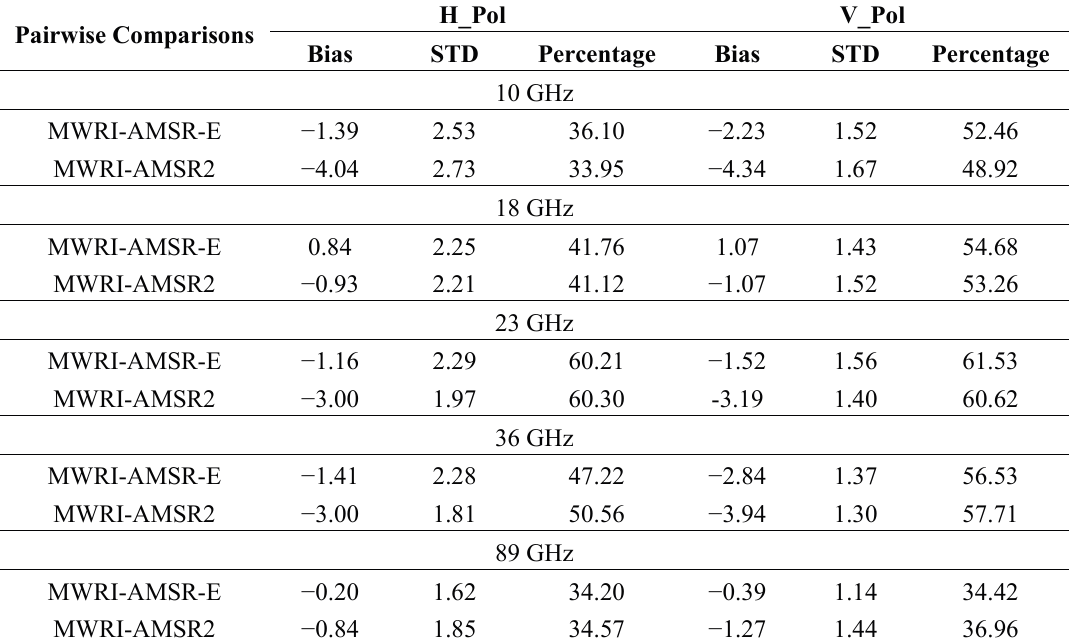
mean biases (Unit: Kelvin) and Standard b